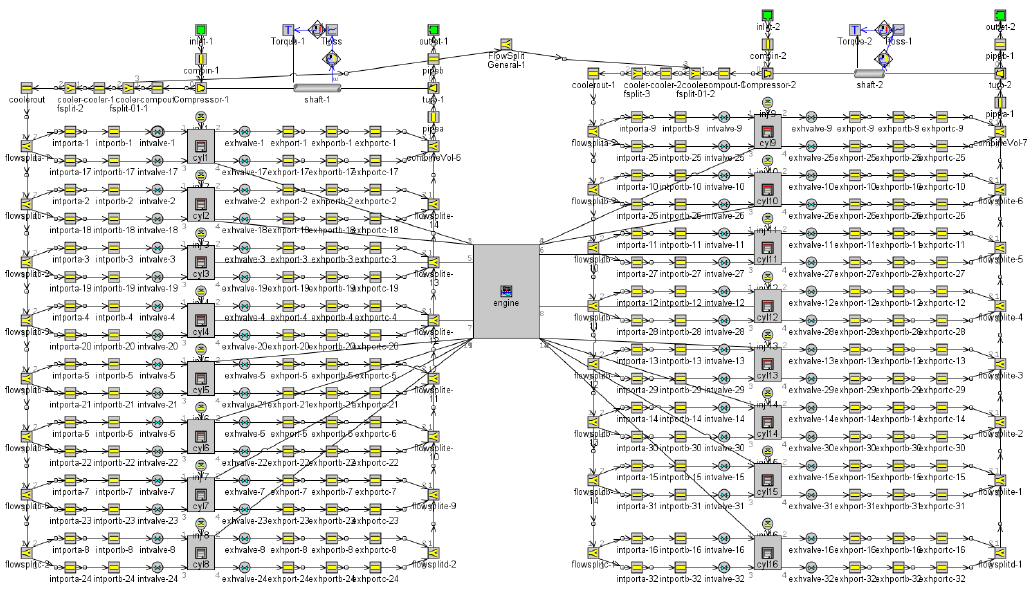
Figure 1. Model of the diesel engine working process.